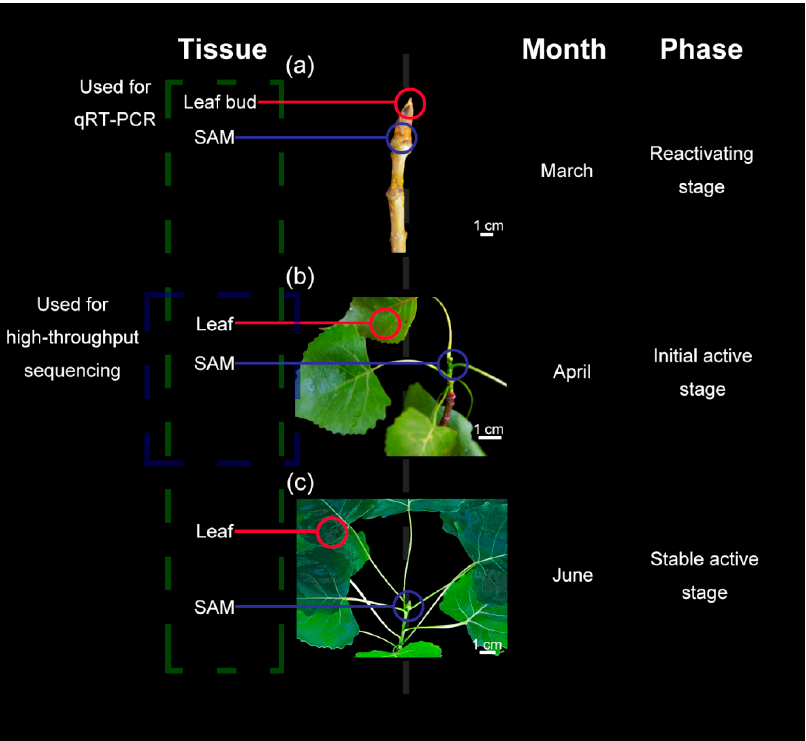
Figure 1. Samples used for high-throughput sequencing and qRT-PCR analyses of P. tomentosa . ( a ) Reactivating stage, ( b ) initial active stage, and ( c ) stable active stage. The materials used for small RNA sequencing (sRNA-seq) are shown in the blue dashed box and those used for qRT-PCR in the green dashed box. SAM: shoot apical meristem.